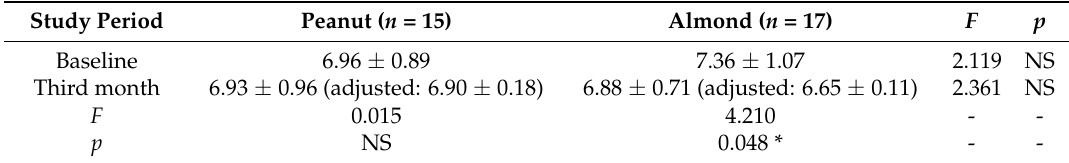
Table 5. Glycated hemoglobin (%) between the two groups in intention-to-treat (ITT). Study Period